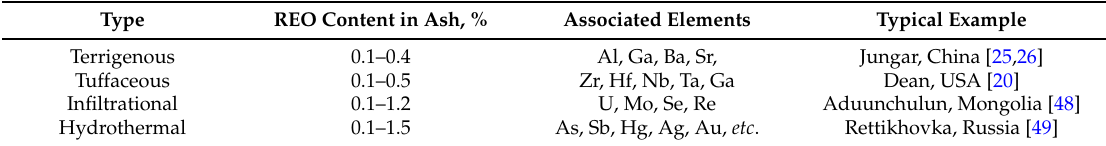
Table 1. The main genetic types of high REY accumulation in coals. After Seredin and Dai [9]. Type REO Content in Ash, % Associated Elements Typical Example